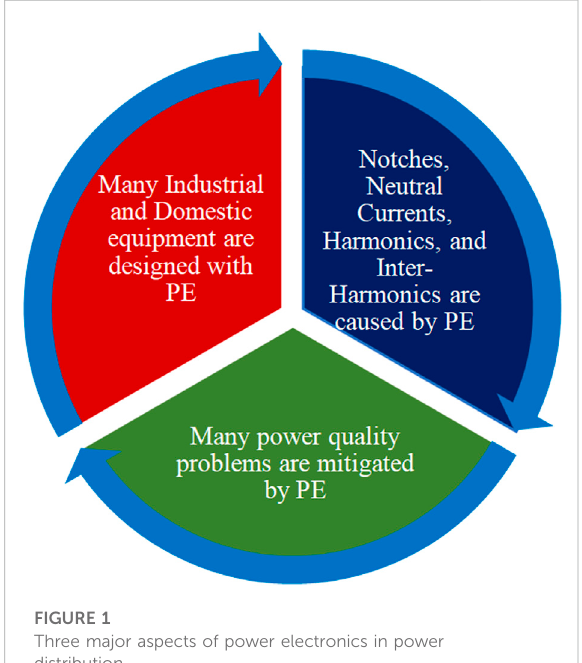
FIGURE 1 Three major aspects of power electronics in power distribution.